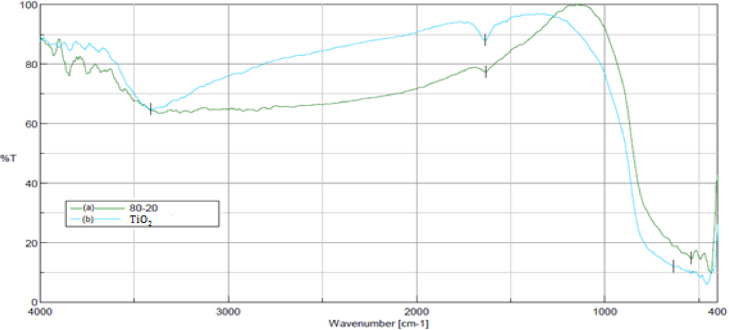
FT-IR spectrum (a) TiO2/Fe3 (80/20), (b) pure TiO2.